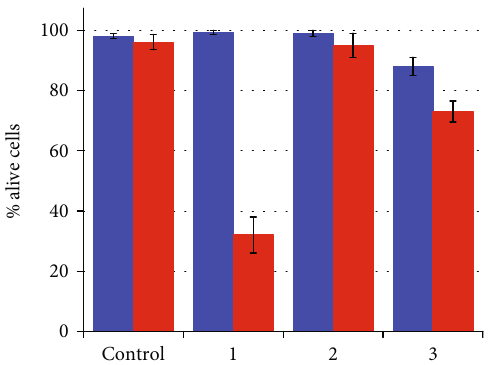
Figure 4: The survival of MCF-7/S cells after treatment with Nanocomposite 1 (1); Nanocomposite 2 (2); and Nanocomposite 3 (3) and in control experiment (control). Blue: “ dark ” measures; red: after